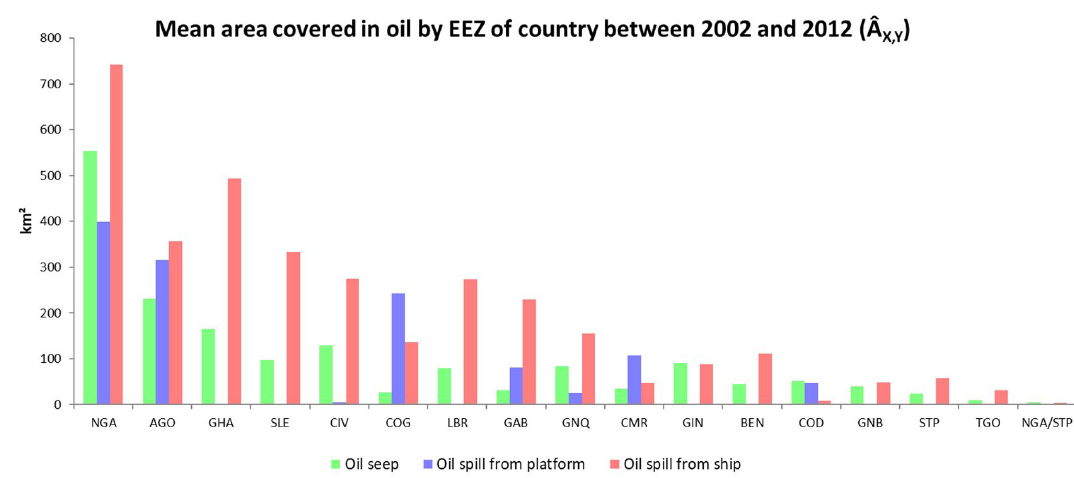
Figure 16. Mean area covered in oil by EEZs of countries (Â X,Y ) in the Gulf of Guinea between 2002 and 2012.